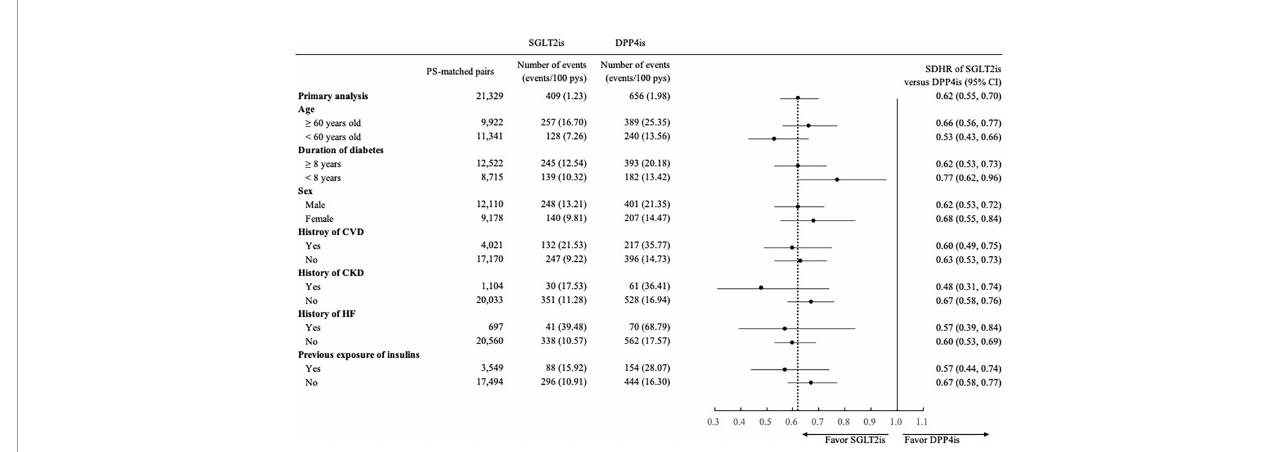
FIGURE 2 | Forest plot of subgroup analyses for 3-point major adverse cardiovascular event (3P-MACE) associated with use of SGLT2is versus DPP4is. SGLT2is, sodium glucose cotransporter-2 inhibitors; DPP4is, dipeptidyl peptidase-4 inhibitors; PS, propensity score; pys, person-years; SDHR, subdistribution hazard ratio; CI, con fi dence interval; CVD, cardiovascular disease; CKD, chronic kidney disease; HF, heart failure. 3P-MACE included non-fatal myocardial infarction, non-fatal stroke, and cardiovascular